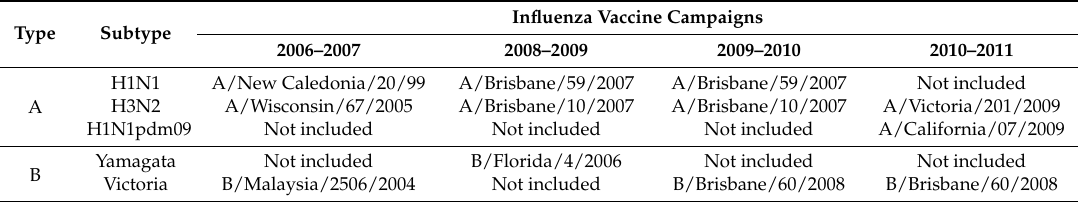
Table 1. A and B influenza strains included in the seasonal influenza vaccines administered to the cohorts, analyzed following the recommended vaccine composition for the Northern Hemisphere 1